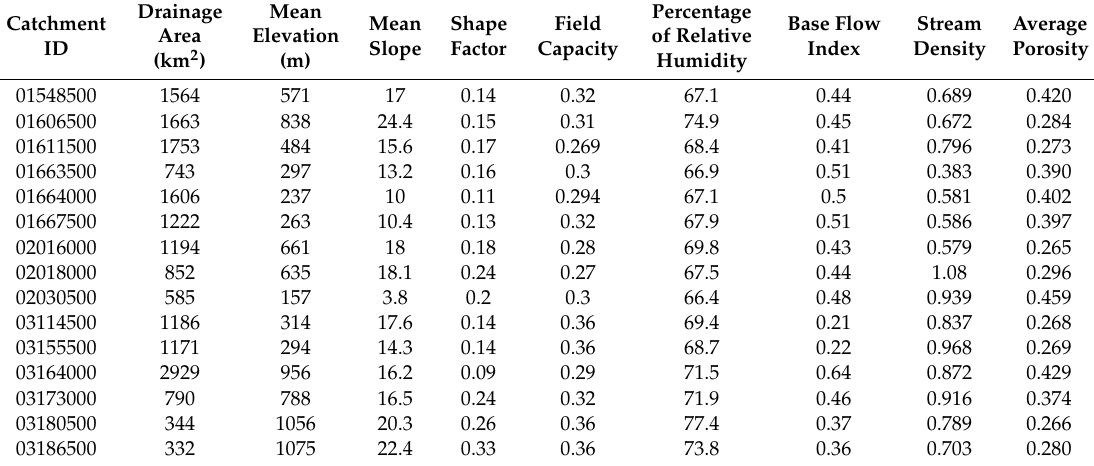
Table 1. Catchment characteristics for the 15 selected model parameter estimation experiment (MOPEX) catchments.